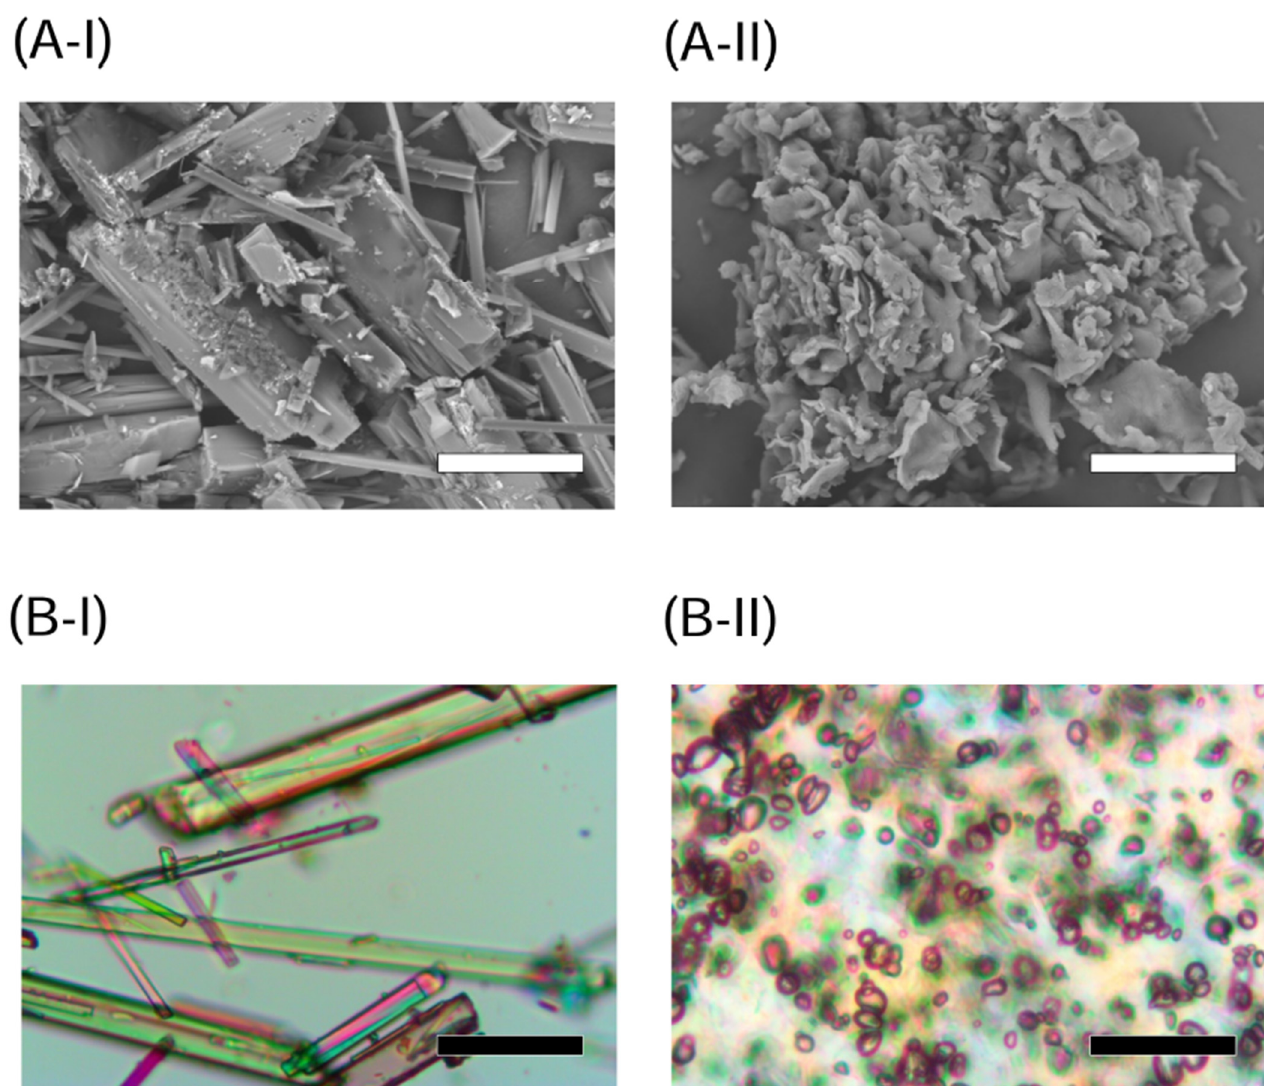
Figure 1. Morphological observations of NOB samples. ( A ) Scanning electron microscopy and ( B ) polarized light microscopy of (I) crystalline NOB and (II) ASD/NOB. White and black bars represent 50 μ m.